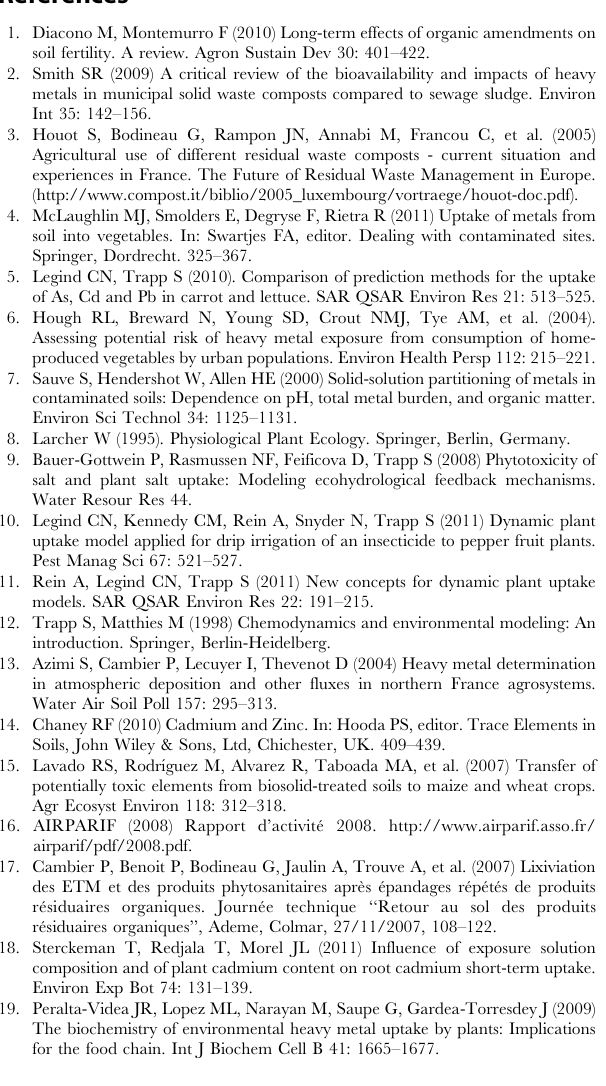
Table S4 Plant mass. Estimated grain, leaf, stem and